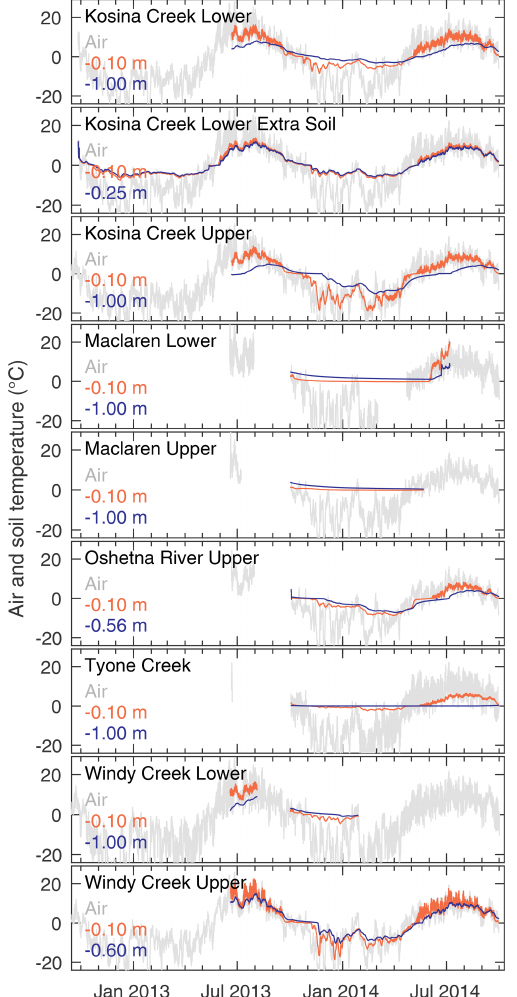
Figure 17. Hourly soil temperatures at depth below the soil surface for all sites with soil data and air temperatures from each site’s sim- ple AWS. Each panel lists the depth of the soil temperature probes.